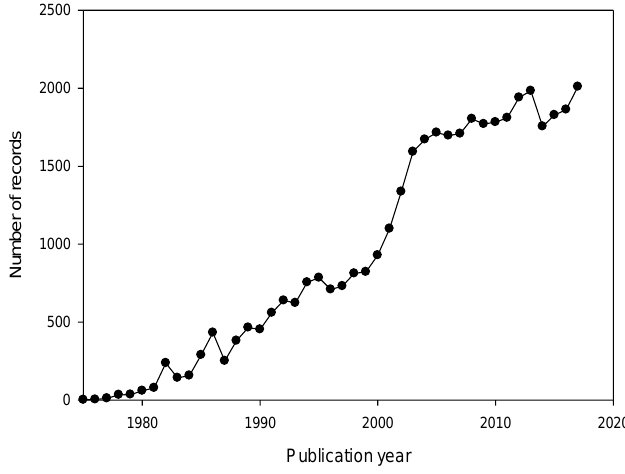
Figure 1. Quantitative growth process of scientific studies concerning clavulanic acid in the period of 1975 – 2017. of